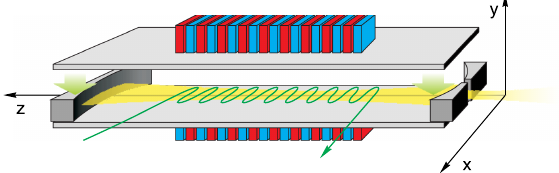
FIG. 2. Schematic of the THz FEL with the parallel plate waveguide and cylindrical mirrors.